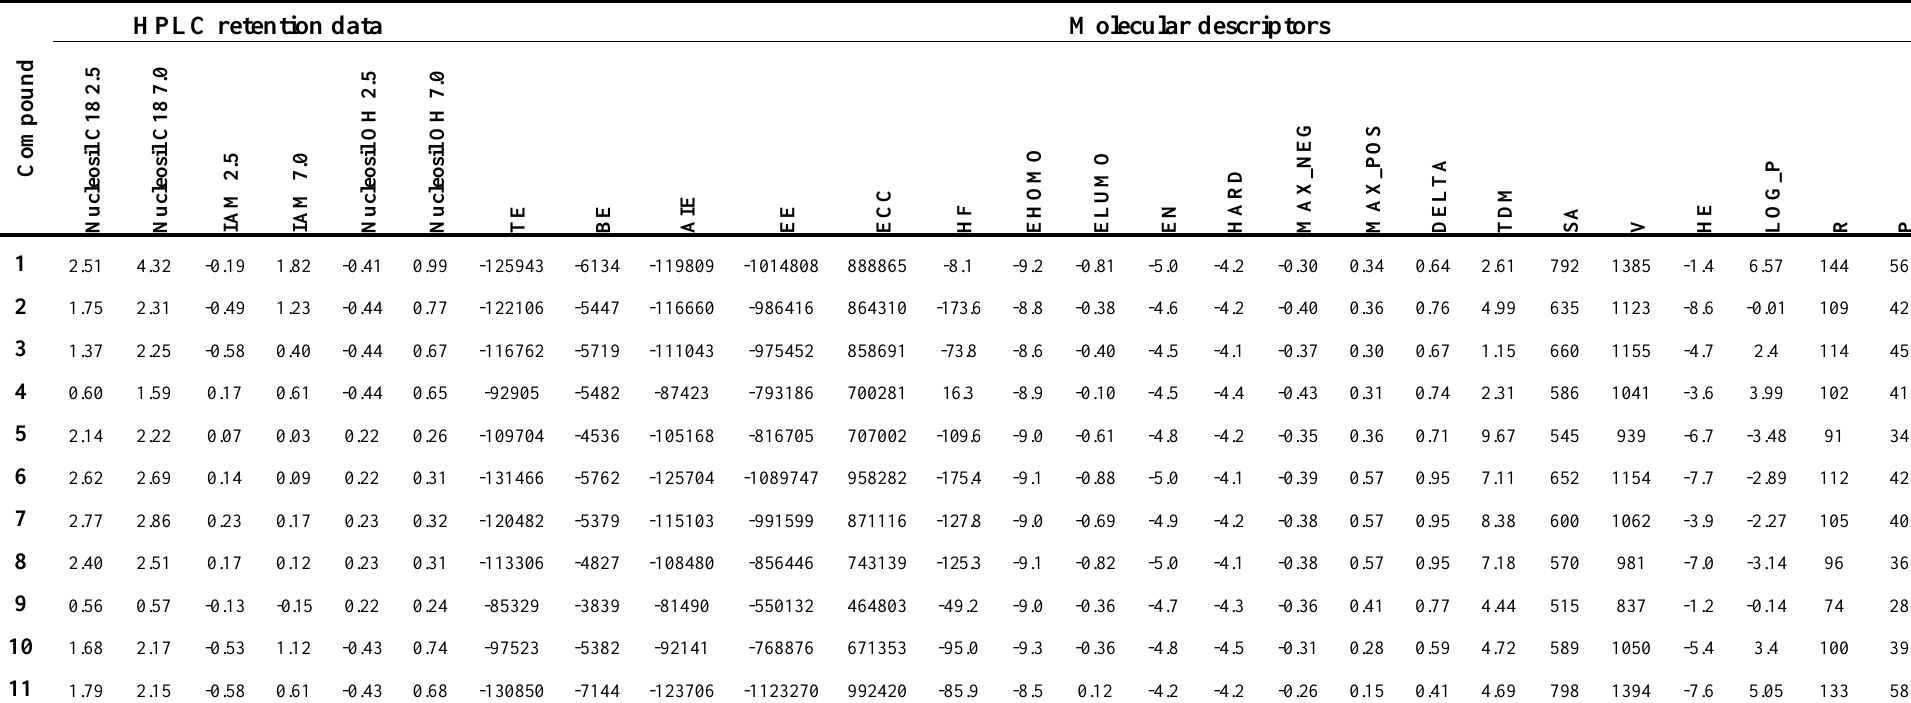
Table 2. Values of HPLC retention data and molecular descriptors used in principal component analysis (PCA). See Materials and methods for HPLC column characteristics and definitions of molecular